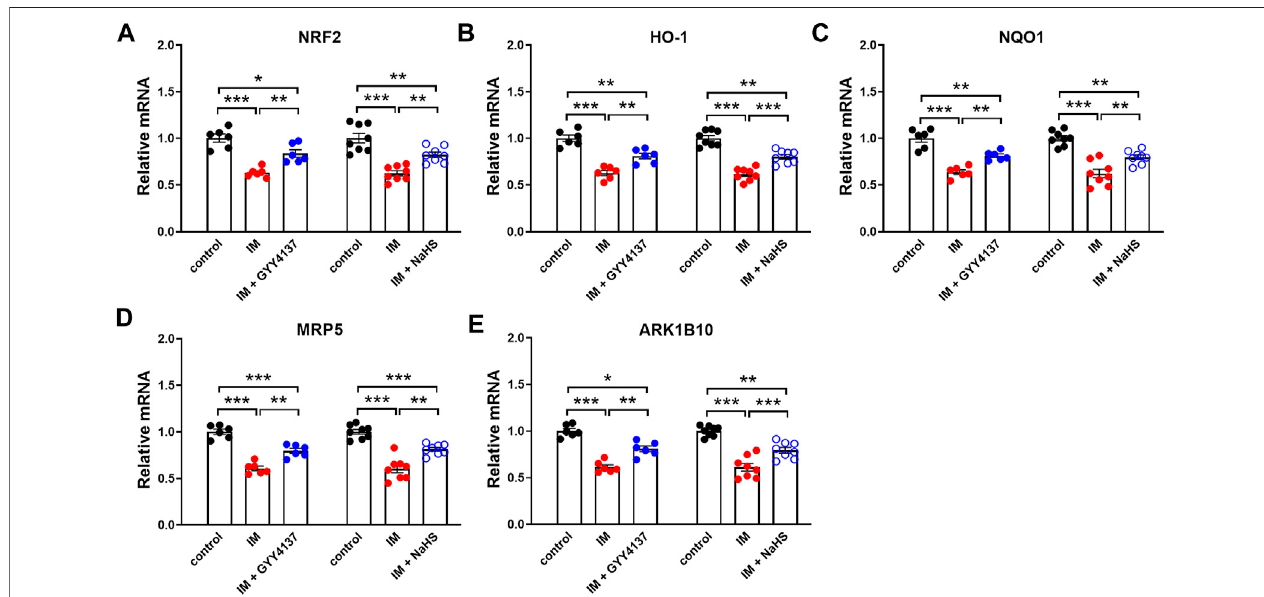
FIGURE 10 | H2S donors protect the IM-induced changes in the mRNA levels of NRF2 and NRF2 downstream target genes in skeletal muscle. Mice were subjectedtoIMand treatedwithGYY4137(50 μ g/kg/d,ip,n=6),orNaHS(1.12 mg/kg,twiceaday,ip,n=8)for2 weeks.Thecontroland IMgroupsreceivedidentical doses of saline for 2 weeks. a-e showed mRNA expressions of NRF2 (A) and NRF2 downstream target genes including HO-1 (B) , NQO1 (C) , MRP5 (D) , and ARK1B10 (E) in TA muscles. Data represent means ± SEM. * p < 0.05, ** p < 0.01, *** p < 0.001.